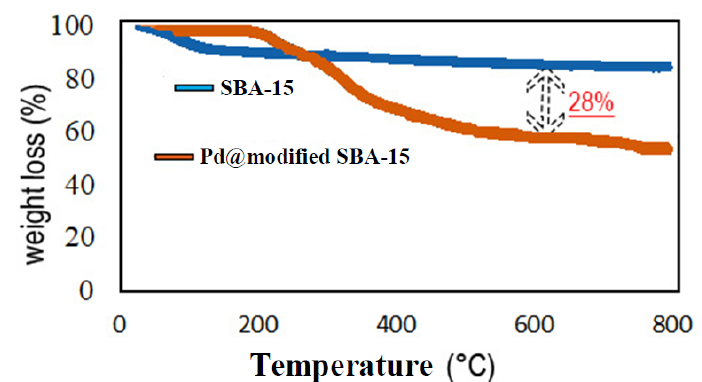
Fig. 7. TGA and DTA curves of SBA-15 and Pd@modified Figure 7. TGA and DTA curves of SBA‐15 and Pd@modified SBA‐15